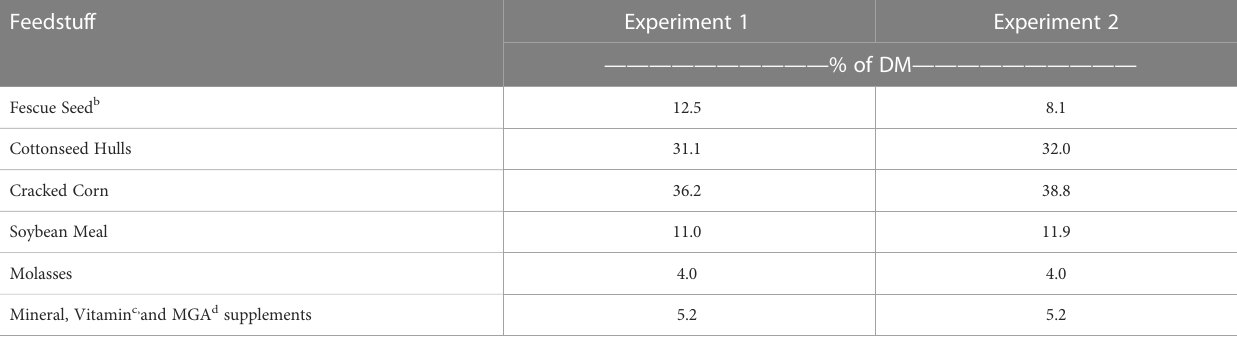
TABLE 1 Feedstuff composition of experimental diets a